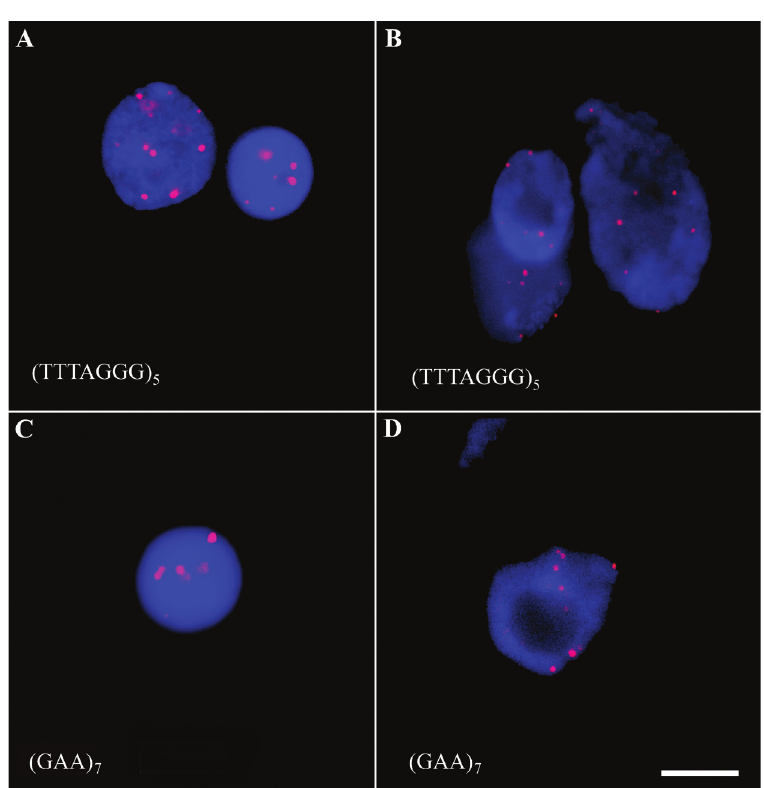
Figure 5. Fast screening of labelling probes was performed by FISHIS on cultivated cardoon (panel A and C ) and globe artichoke (panel B and D ) nuclei suspensions. The nuclei with the clearest and discrete telo- meric (TTTAGGG) and SSR (GAA) signals are shown. All oligonucleotides were fluorescently labelled by 5 7 Cy3 (red fluorescence). Nuclear DNA was counterstained with DAPI (blue fluorescence). Scale bar: 5